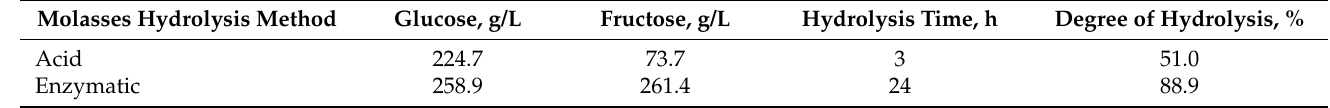
Table 1. Indicators of sucrose hydrolysis and the composition of hexoses